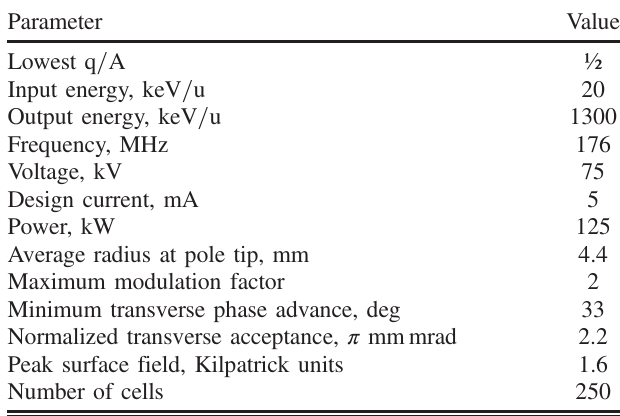
TABLE I. RFQ design